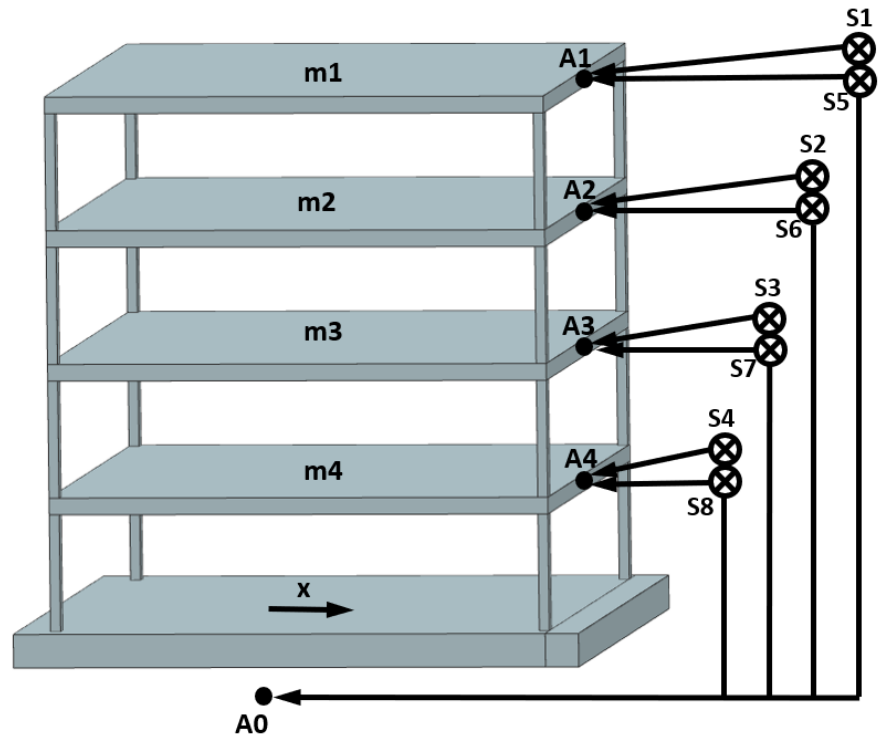
Figure 11. Arrangement of markers (A1–A4), and sensors (S1–S8).